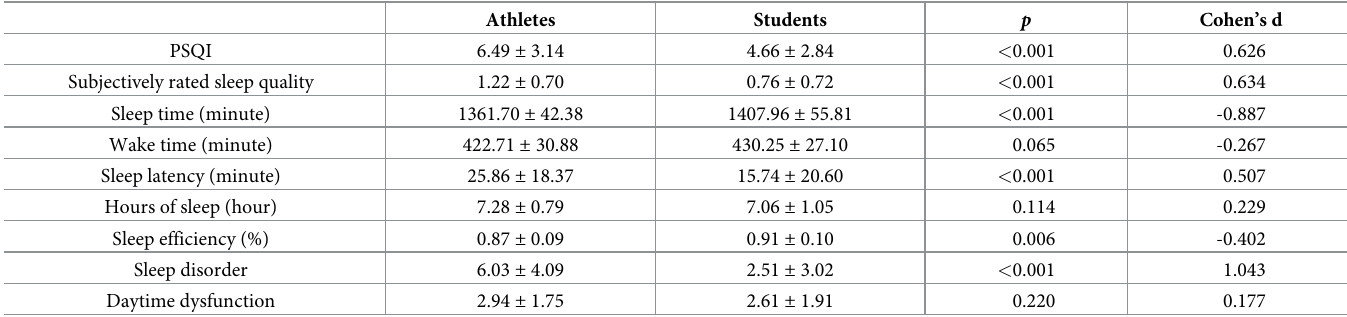
Table 3. Descriptive results of sleep quality of athletes and students ( M ± SD ).